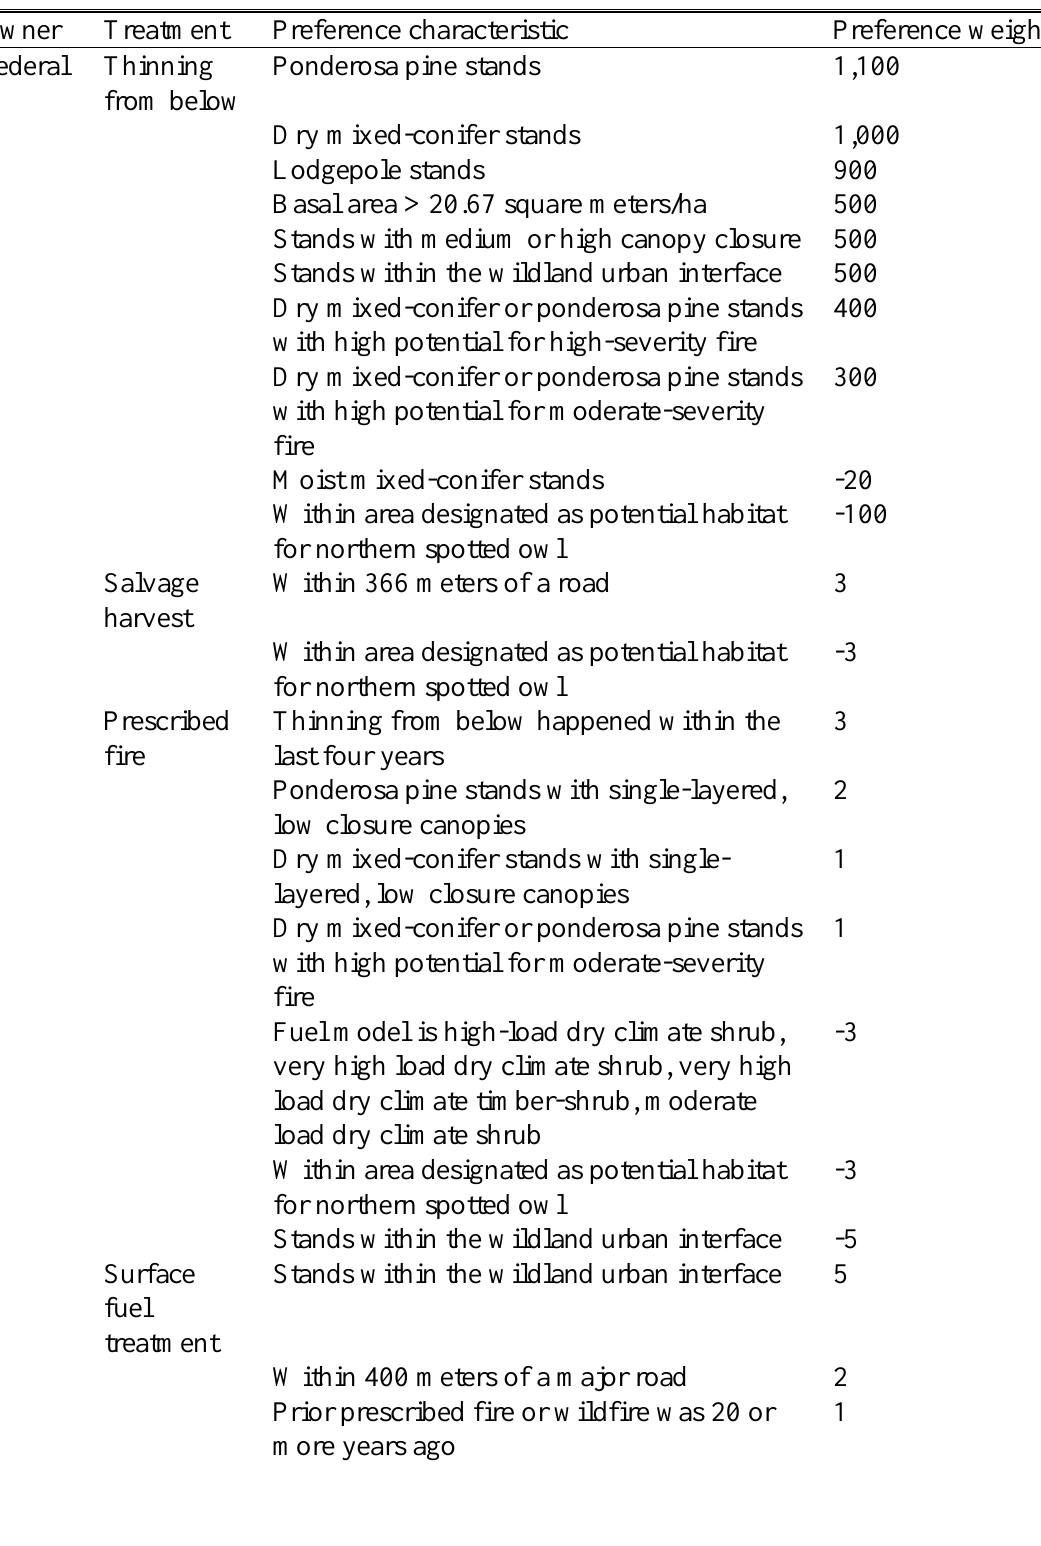
Table A6.1. Preferences and weights used in Envision for for management treatments of IDUs by large land